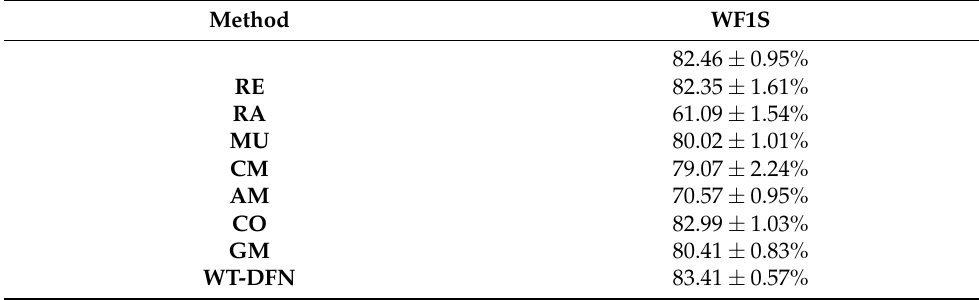
Table 2. Comparisons with state-of-the-art augmentation methods on C-NMC.